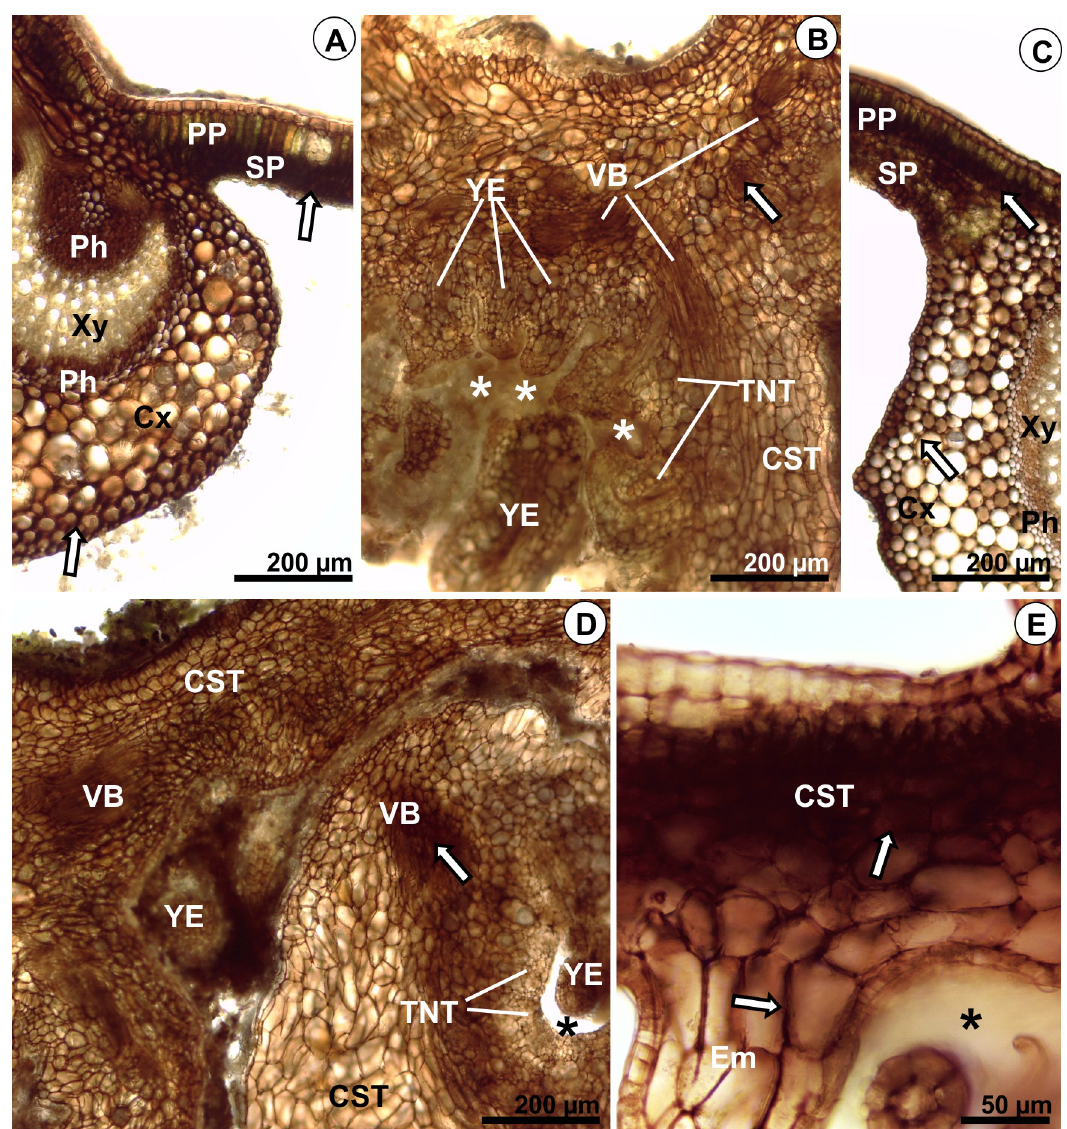
Fig 5. Histochemistry of hydrogen peroxide (H 2 O 2 ) in leaves and galls of Ditylenchus gallaeformans (Nematoda) on Miconia albicans and M . ibaguensis , and Eriophyidae galls on M . ibaguensis . Transverse sections. The asterisks indicate the gall chambers; the arrows indicate accumulation of hydrogen peroxide. (A-B) M . albicans . (A) Midrib and mesophyll of control leaves. (B) Nematode gall. (C-F) M . ibaguensis . (C) Midrib and mesophyll of control leaves. (D) Nematode gall. (E-F) Eriophyid gall. Abbreviations: CST , common storage tissue; Cx , cortex; Em , emergence; Ph , phloem; PP , palisade parenchyma; SP , spongy parenchyma; TNT , typical nutritive tissue; VB , vascular bundle; Xy , xylem; YE , young emergences. Staining: 0.5% 3,3 0 - diaminobenzidine